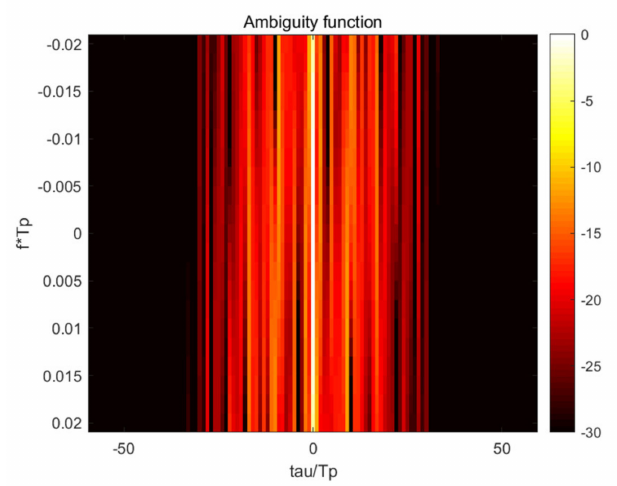
Figure 1. Ambiguity function before